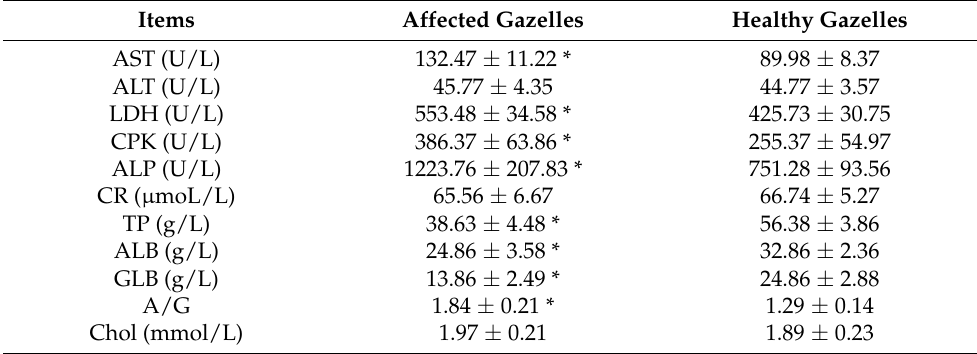
Table 4. Physiological and biochemical levels in blood in